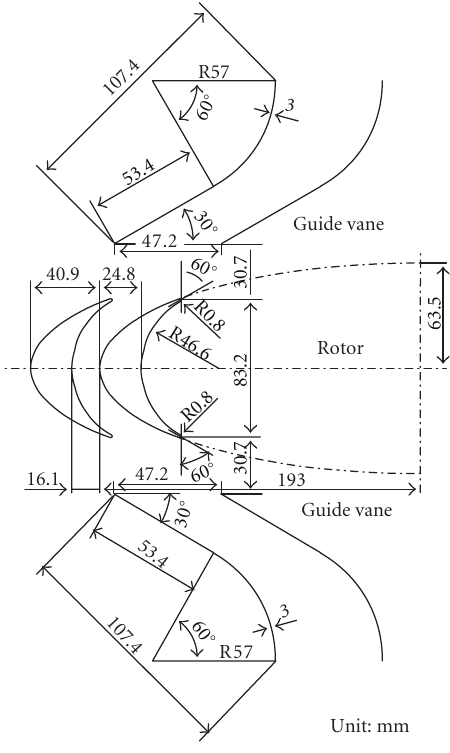
Figure 16: Configuration of impulse turbine.